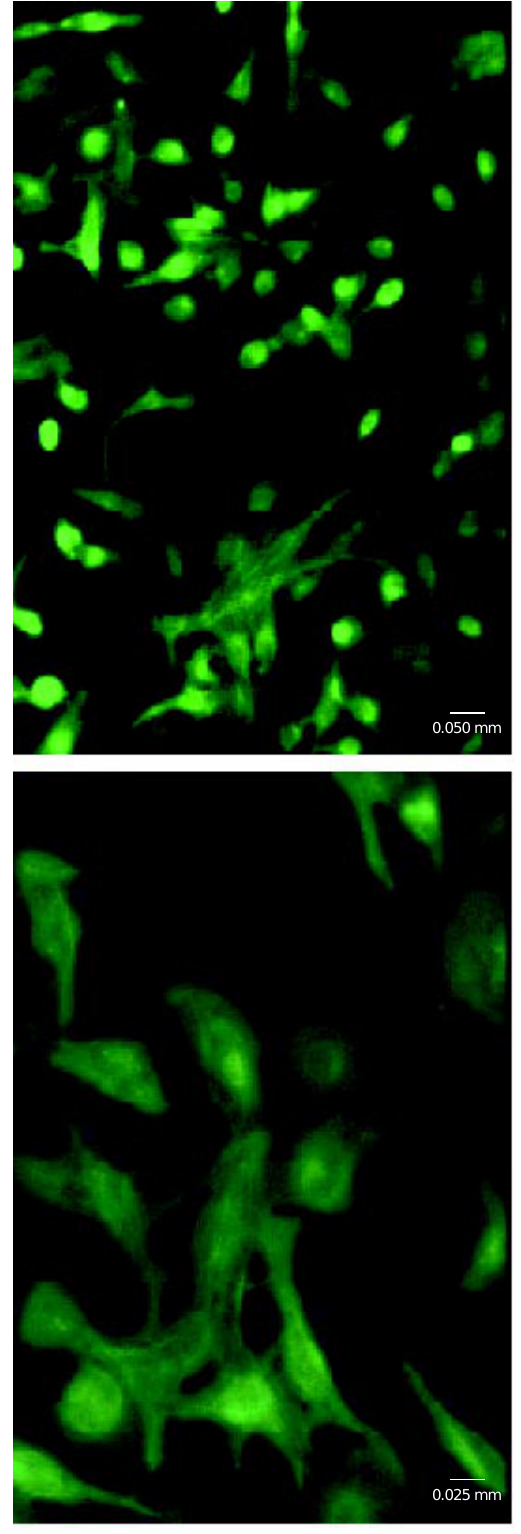
Figure 1 - Neonatal rat car- diomyocytes in culture. Im- munofluorescence shows cells stained with anti-tro- pomyosin (sarcomeric) anti- body, which reacts specifi- cally with striated muscle. Magnification 100X (top) and 200X